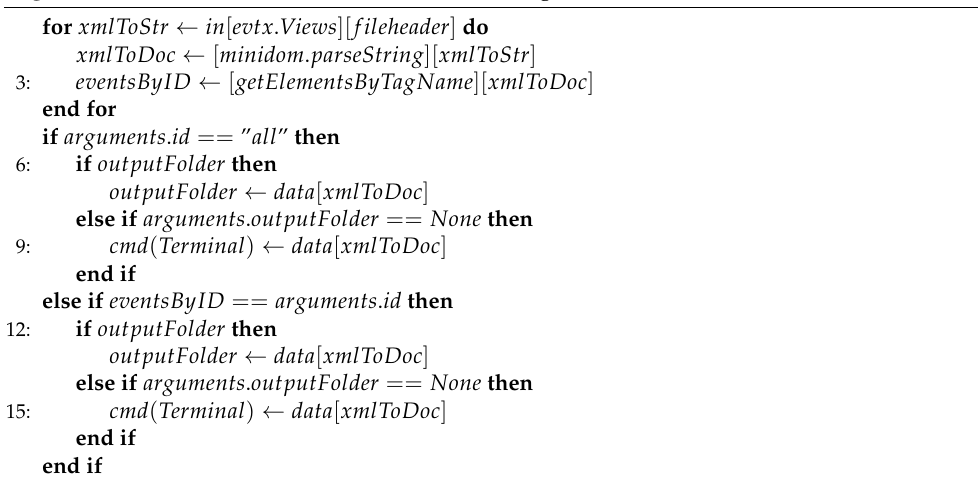
Algorithm 2 PeX’s evtx-to-xml transformation